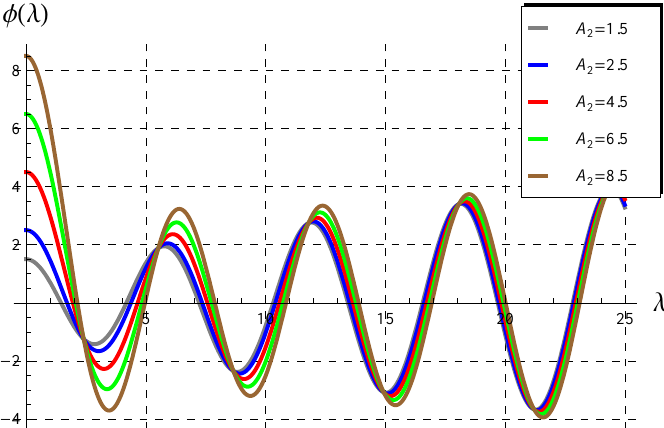
Figure 2. Behavior of φ ( λ ) vs. λ in the range 1 ≤ A 2 <